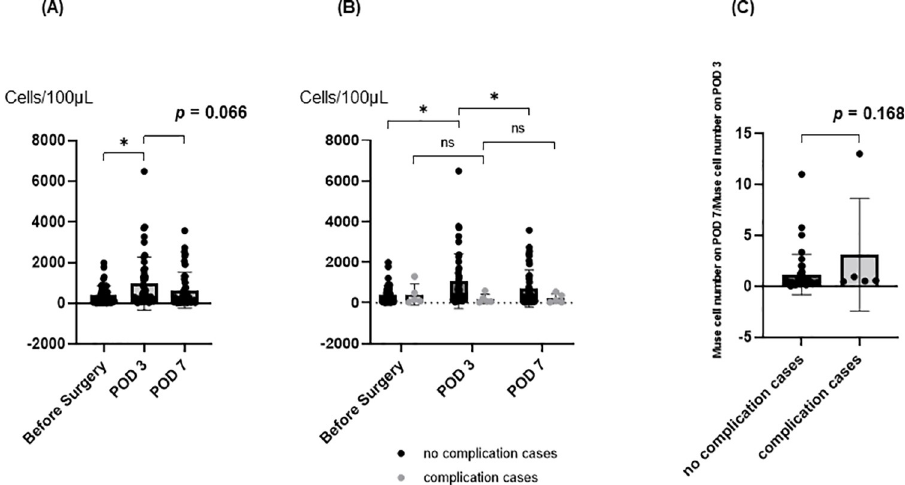
Fig 3. Muse cell numbers in peripheral blood. A: Changes in the Muse cell number in peripheral circulating blood after hepatectomy. B: Changes in the Muse cell number in peripheral circulating blood after hepatectomy for complication and no-complication cases. C: The rate of PB-Muse cell number changes from postoperative days (PODs) 3 to 7 (PB-Muse cell number on POD 7/PB-Muse cell number on POD 3) in complication and no- complication cases. � p <